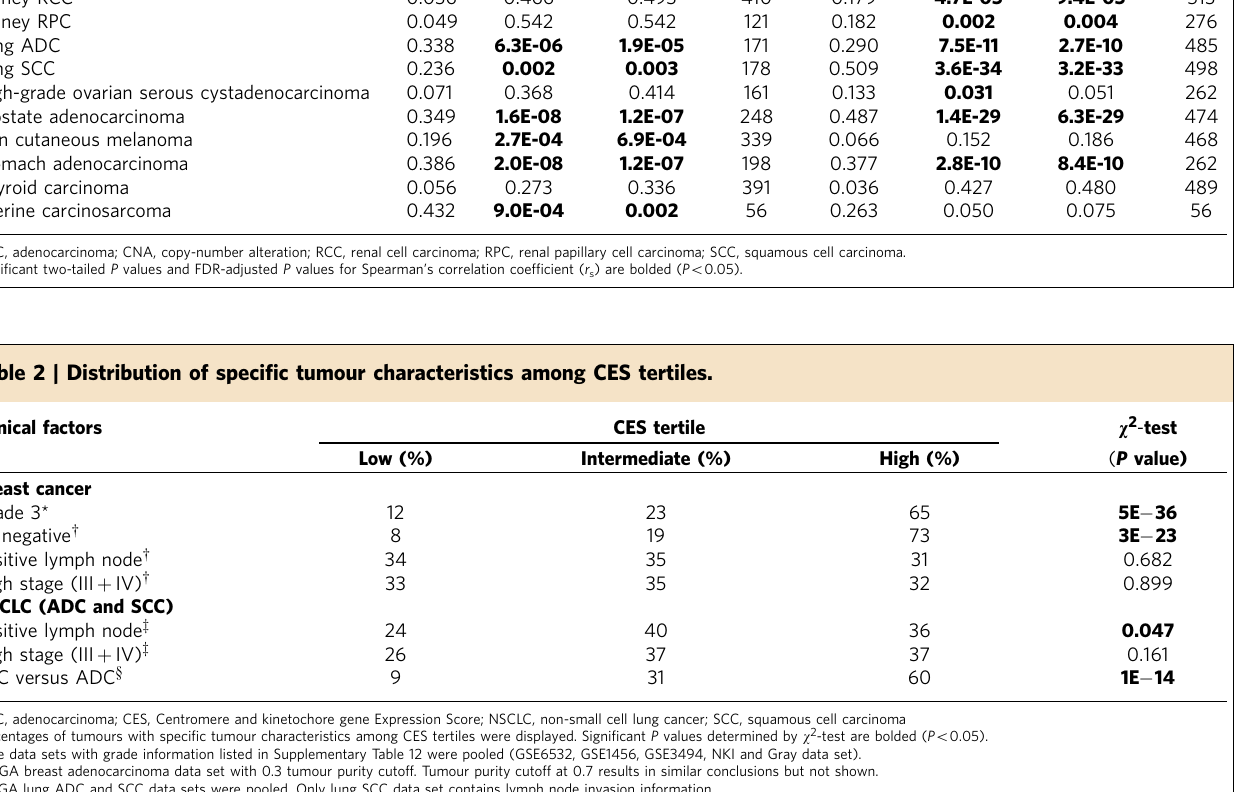
Three NSCLC data sets containing histological subtype information listed in Supplementary Table 13 were pooled (GSE14814, GSE42127 and